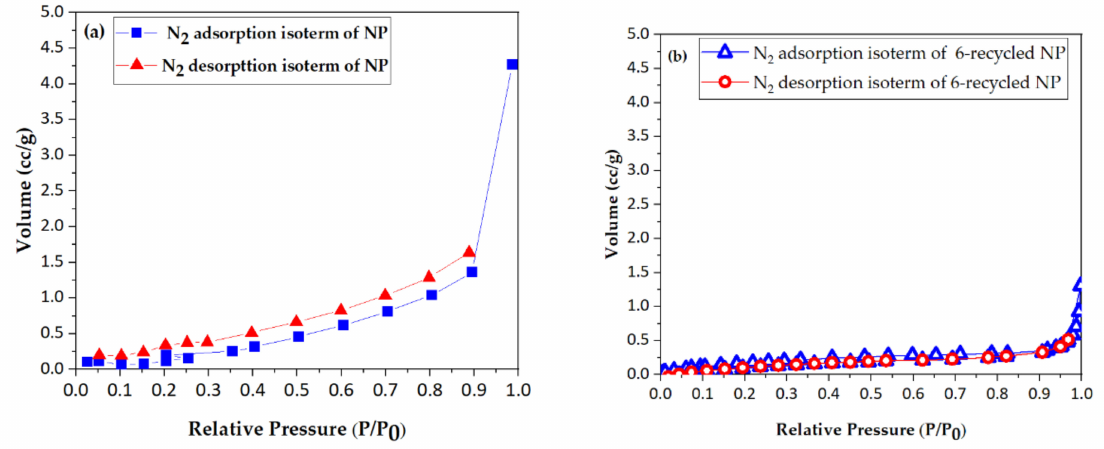
Figure 4. N 2 adsorption–desorption isotherm (BET) of: ( a ) NP, and ( b ) 6-recycled NP. Pore volume and size distributions of NP and 6-recycled NP were analyzed by using the BJH method for the N 2 adsorption branch isotherms (Figure 5, Table 2). The surface areas of these particles are considered low [54] as per S BET = 2.081 and S BJH = 1.948 m 2 g − 1 for NP, and S BJH = 0.761 and S BJH = 0.426 m 2 g − 1 for recycled NP. There is no noticeable porosity as per the pore volume of 0.007 cm 3 g − 1 for NP with the average size of 3.675 nm, and 0.001 cm 3 g − 1 for 6-recycled NP with the average pore size of 5.784 nm. These results are in good agreement with the reported data for Morocco natural phosphate [12,55]. By comparing the specific surface area and average pore volume of NP and 6-recycled NP, it